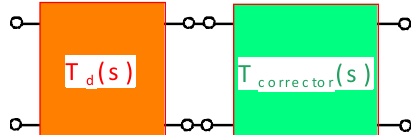
Figure 1: Disturbing system in cascade with the correction